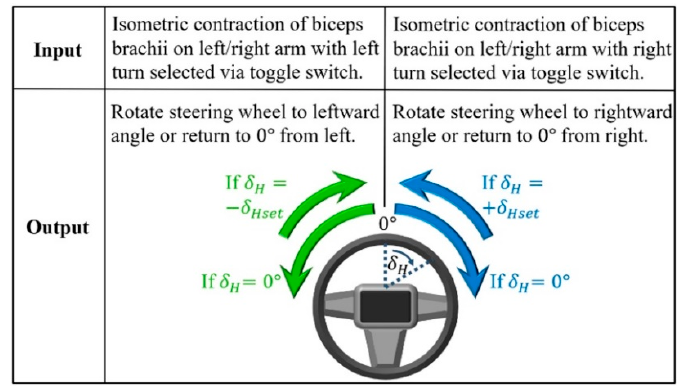
Figure 3. Relation between muscle contraction input and steering wheel angle output.